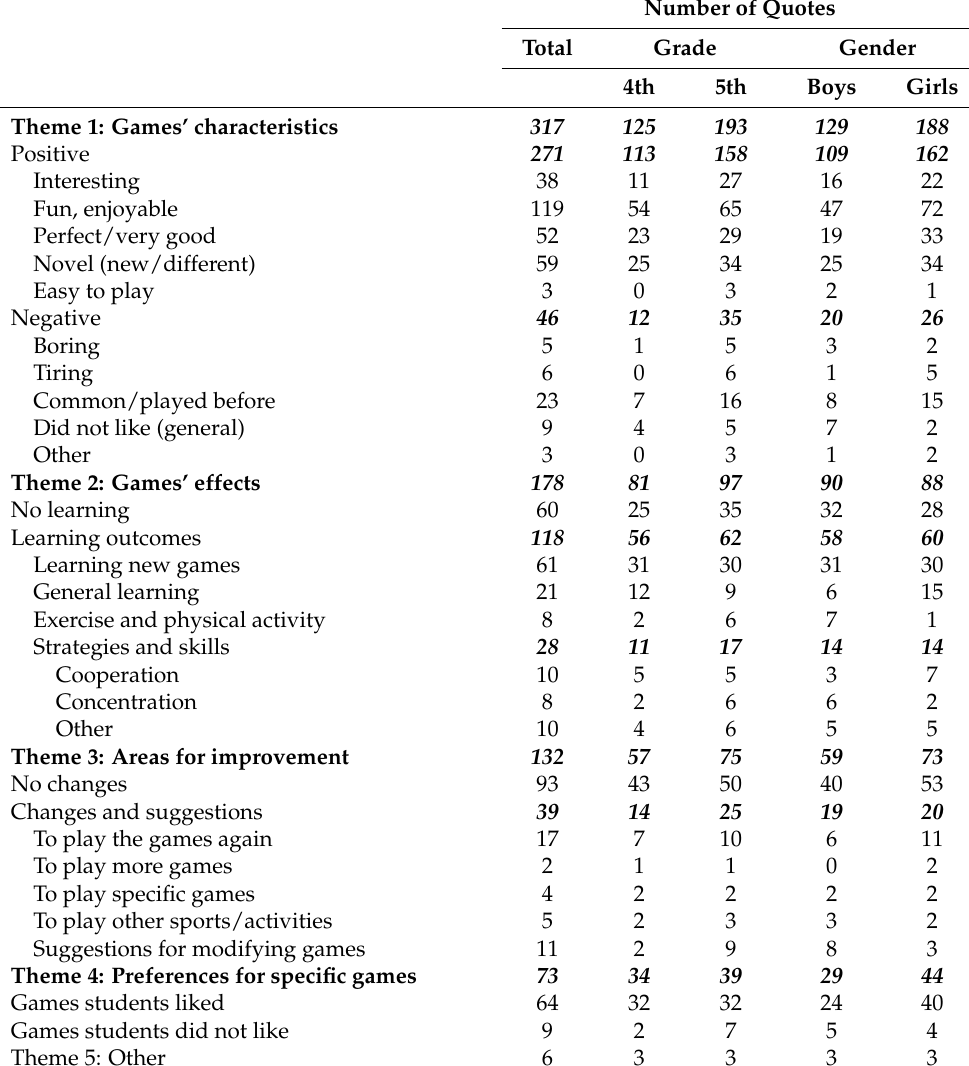
Table 1. Thematic structure of the data and frequencies of the